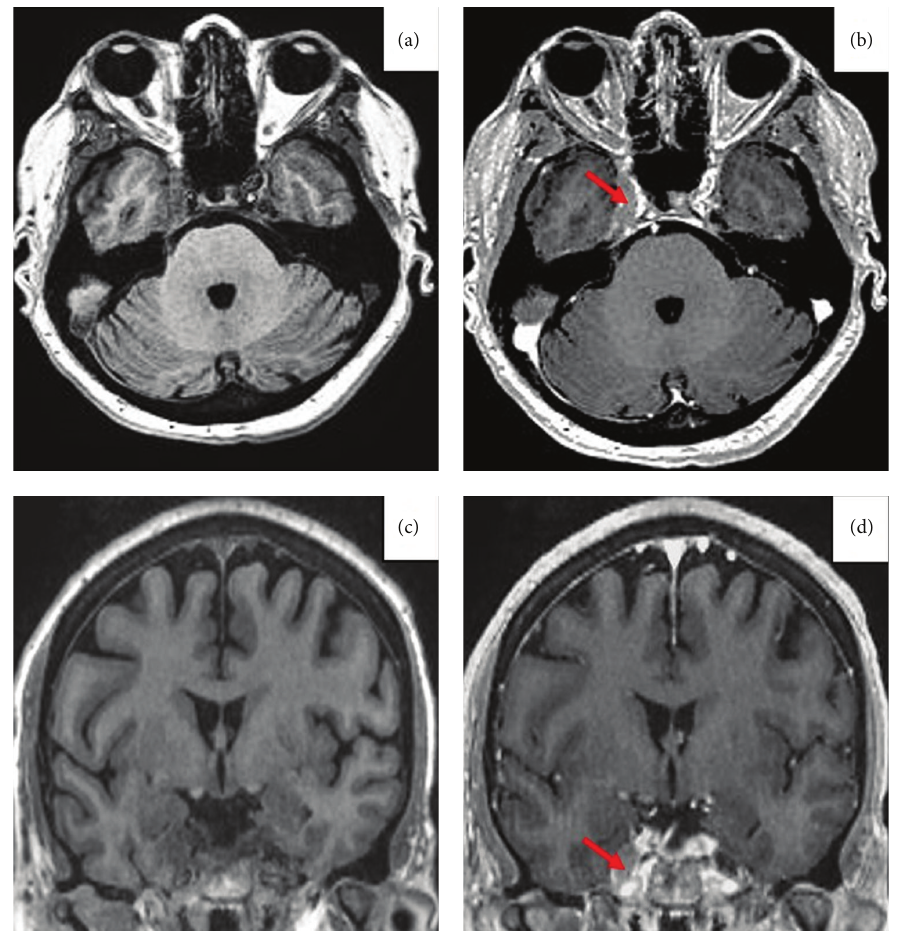
Figure 2: Transverse plane in T1W without (a) and with contrast (b) showing V nerve exiting the Gasserian ganglion (red arrow). Coronal plane in T1W without contrast (c) and with contrast (d) showing increased volume of the Gasserian ganglion in Meckel’s